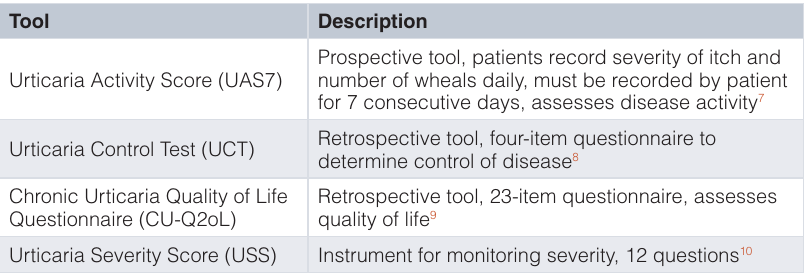
Table 2. Tools to assess the impact of chronic urticaria on quality of life. There are a number of recently developed tools specifically for urticaria to assess severity and impact on quality of